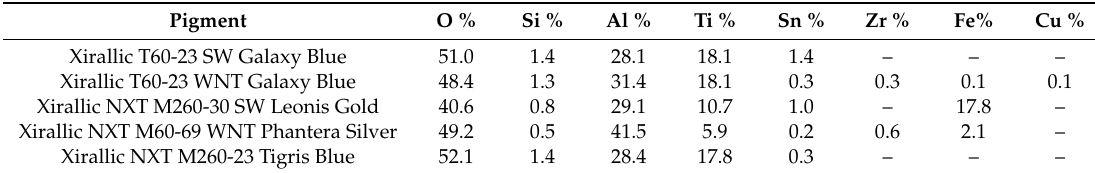
Table 2. EDS analysis of the studied